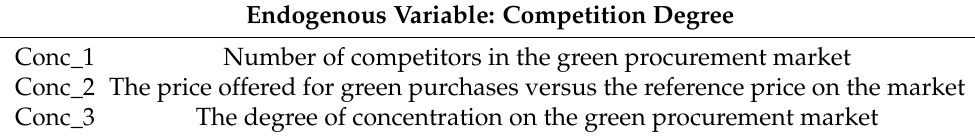
Table 2. Description of the dependent variable.